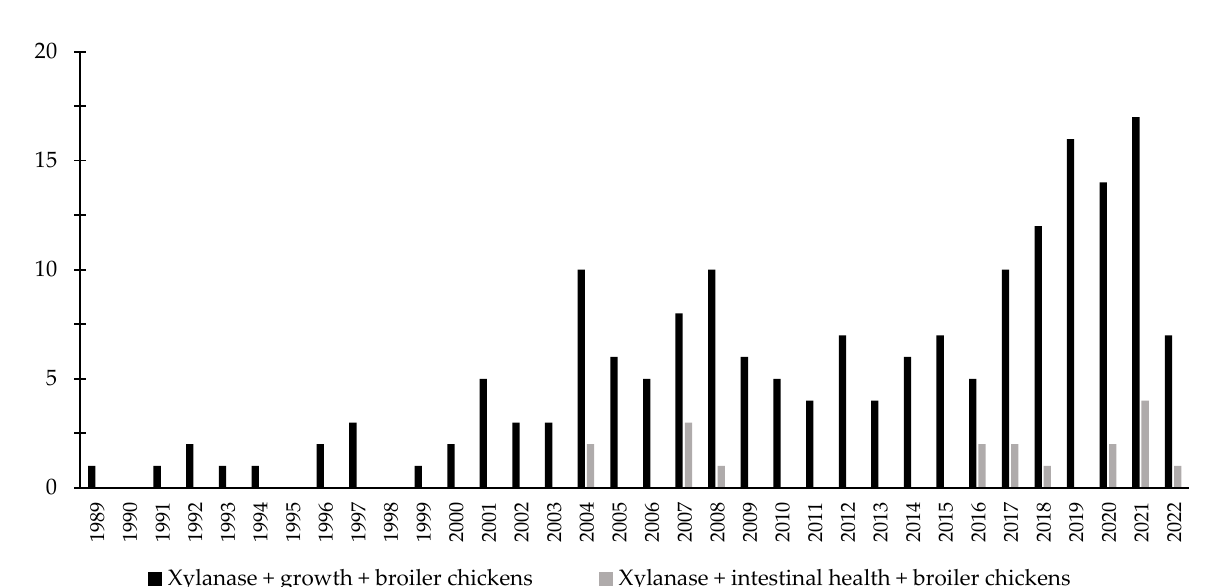
Figure 7. A list of the number of peer-reviewed papers found in the PubMed using different keywords. Black bars: xylanase, growth, broiler chickens as key words; grey bars: xylanase, intestinal health, broiler chickens as keywords.